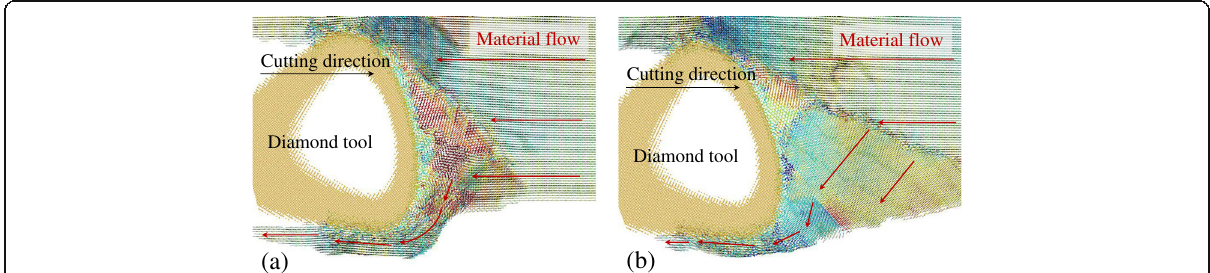
Fig. 16 Displacement vector plots at inclination angle of ( a ) 14° and ( b ) 20° in cutting direction of {100} <